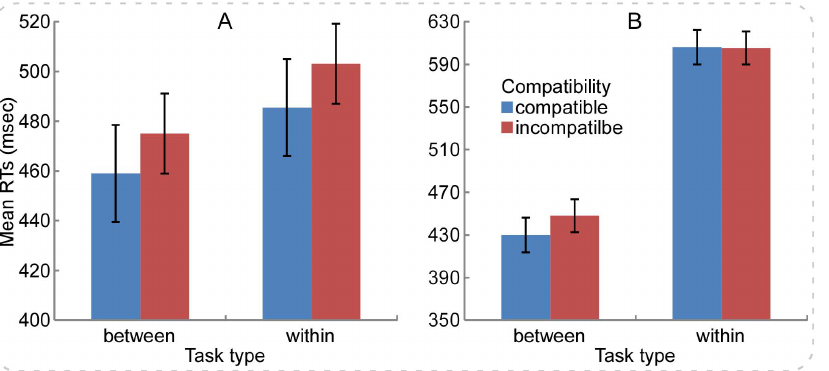
Figure 2. The RTs results for Experiment 3. Panel A illustrates the RTs results for Experiment 3A with the between-category color task preceding the within-category color task. It is notable that the Simon effect is clearly observed and the RTs levels are similar in both tasks. Panel B illustrates the RTs results of Experiment 3B with the with-category color task preceding the between-category color task. Similar to Experiments 1 and 2, Experiment 3B reveals significant Simon effect in the between-category but not within-category tasks. Error bars indicate 6 1 SEM s as calculated by the pairwise difference method ( SEM pairedDiff ) [39].